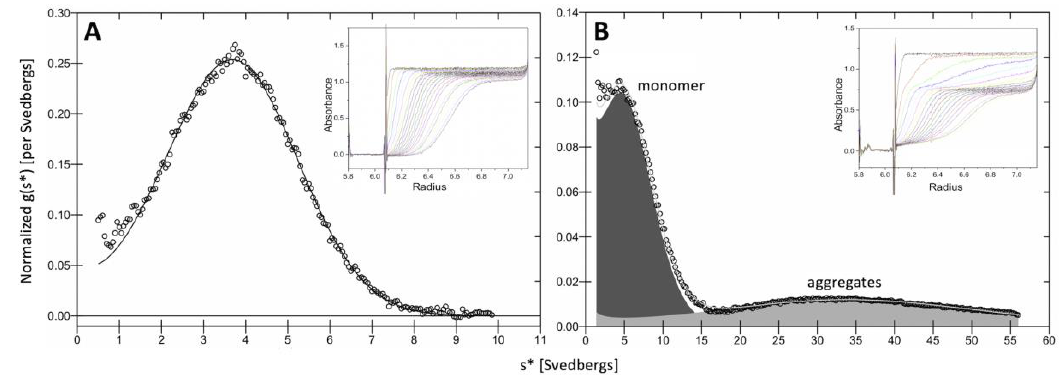
Figure 1. Sedimentation velocity analysis of Tyrp1tr sample. Graphs show the sedimentation coefficient distributions in the samples stored at 4 °C (Panel A ) and pre-incubated at 37 °C × 24 h (Panel B ). Raw data are shown by open circles; a line represents the best fit. The inserts show the SV analysis of experiments conducted at 40,000 rpm, 20 °C.